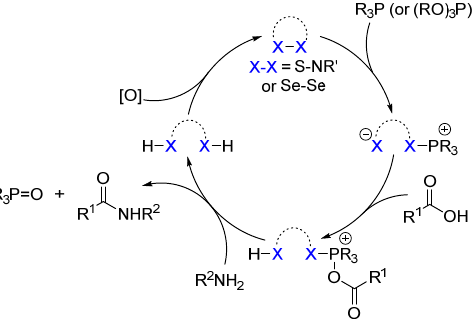
Scheme 17. General mechanism using S ‐ N ‐ and Se ‐ Se ‐ based organocatalysts.